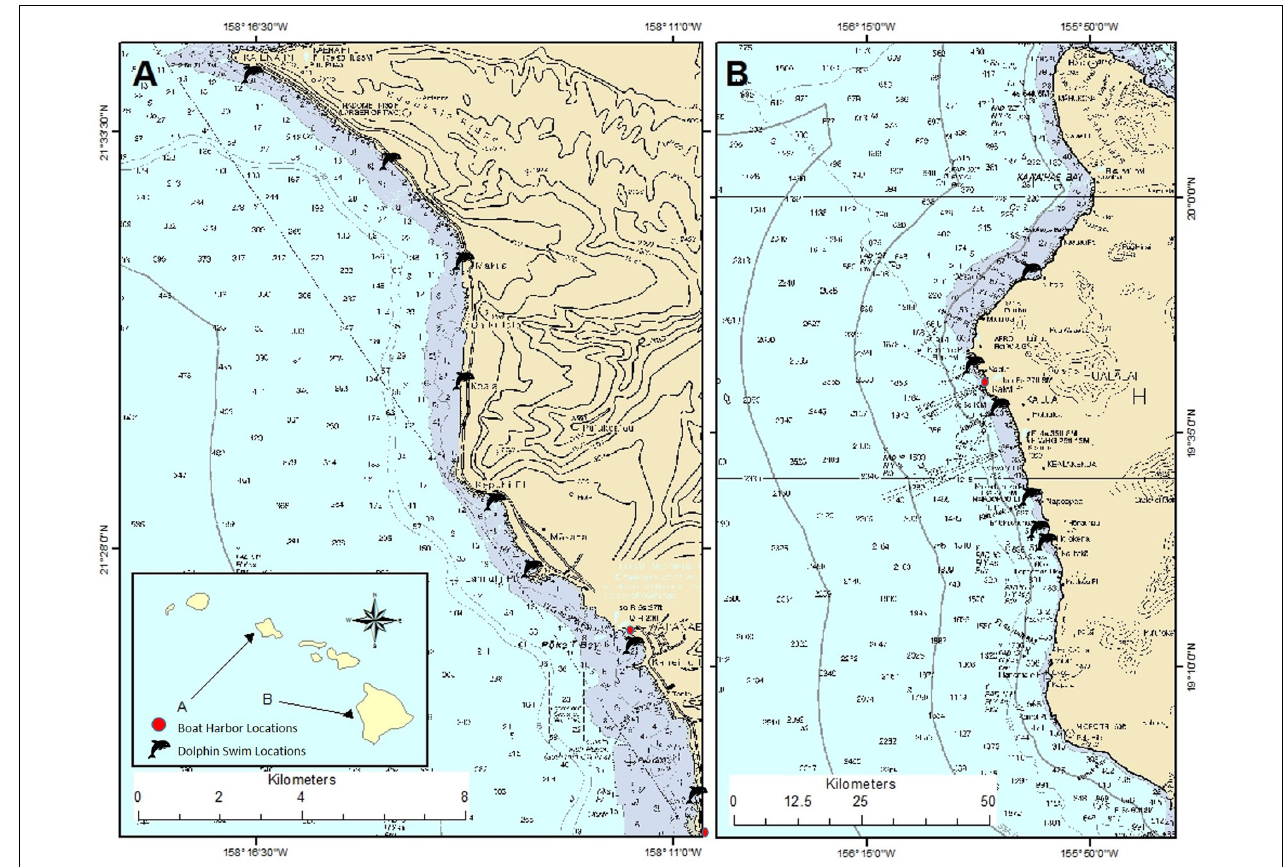
FIGURE 2 | Map of dolphin-swim locations on (A) Waianae, O’ahu and (B) Kailua-Kona, Hawai’i Island. Base map: NOAA created in ArcGIS (GIS